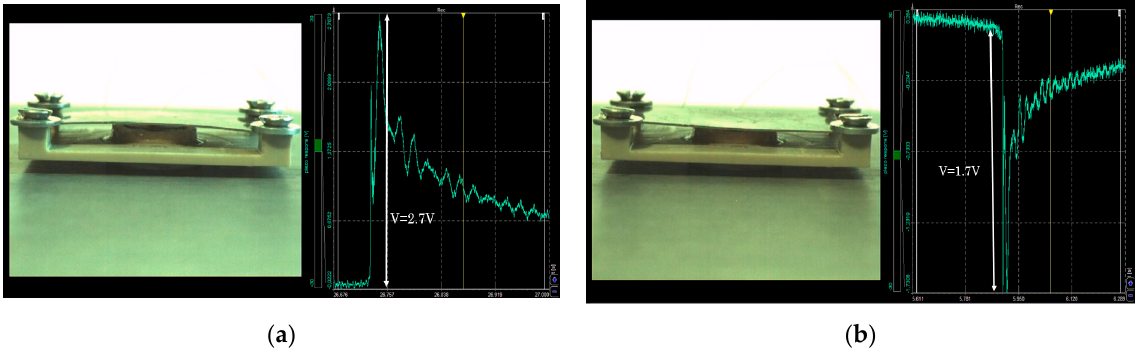
Figure 7. ( a ) Electrical signal of the piezoelectric bimetal during its snap-up (sample 6/30/4) and ( b ) during its snap back.